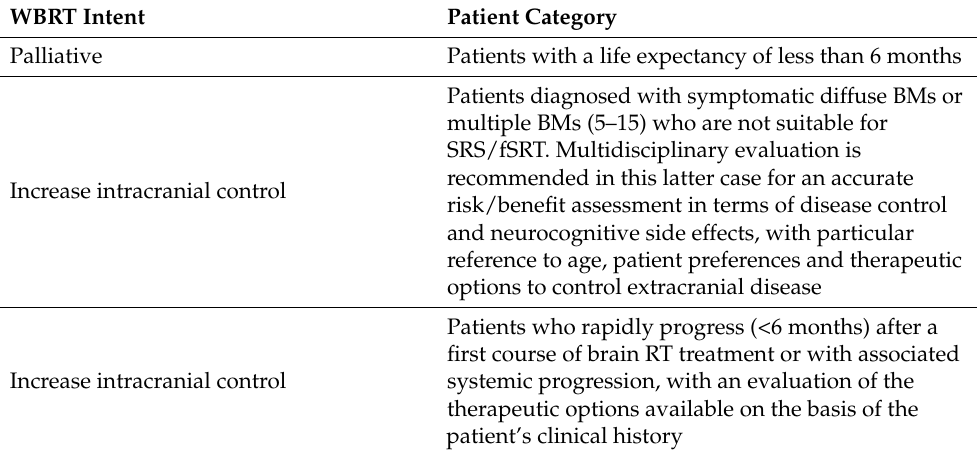
Table 5. Patient candidates for